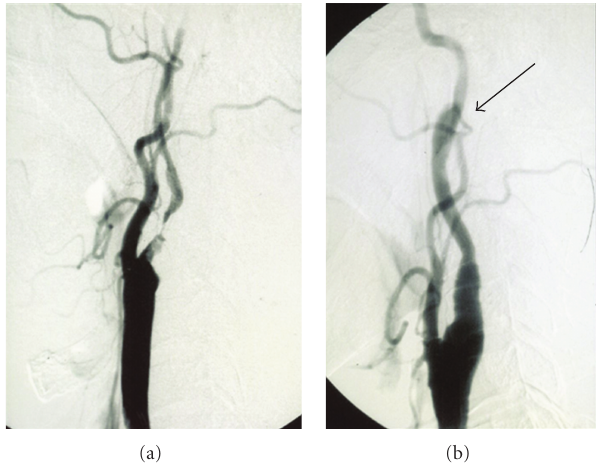
Figure 2: (a) Preoperative left carotid angiogram showing severe stenosis of the left internal carotid artery. (b) Postoperative left carotid angiogram showing dissecting formation (arrow) at the several centimeters distal to the operative site and improvement of stenosis.